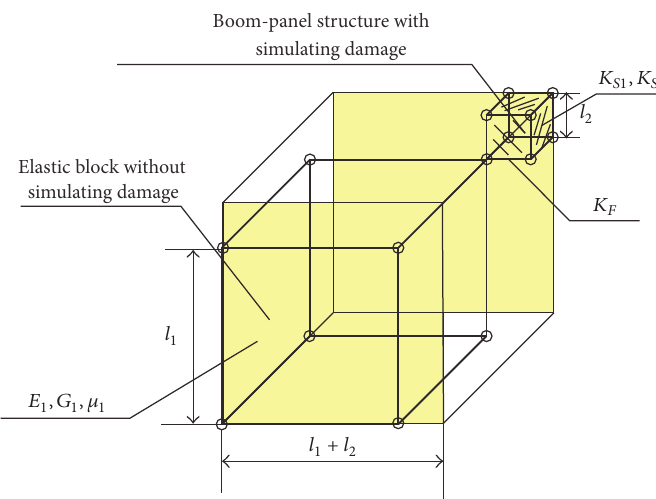
Figure 3: The minimum cell of the